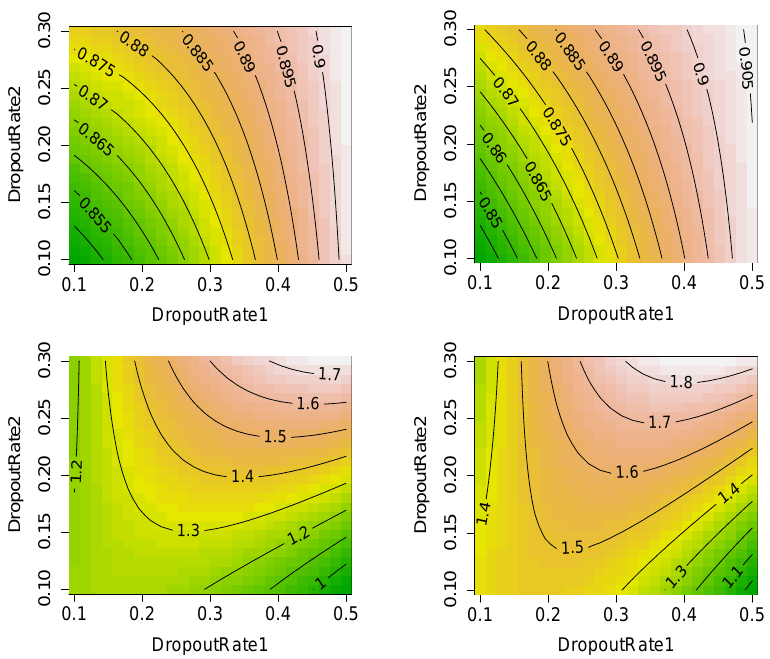
Figure A3. RSM for observing the effects of dropout rates on the validation and classification accuracy on the first row and for the corresponding loss values on the second